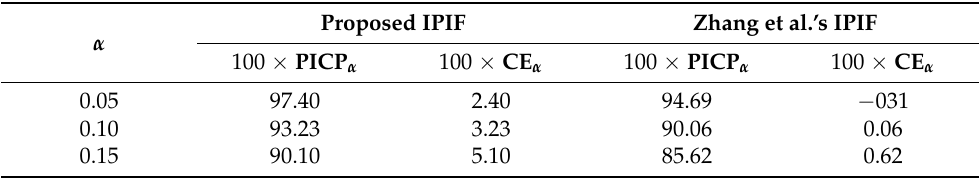
Table 12. Comparison of computed error metrics’ comparison for our proposed IPIF and Zhang et al.’s IPIF.